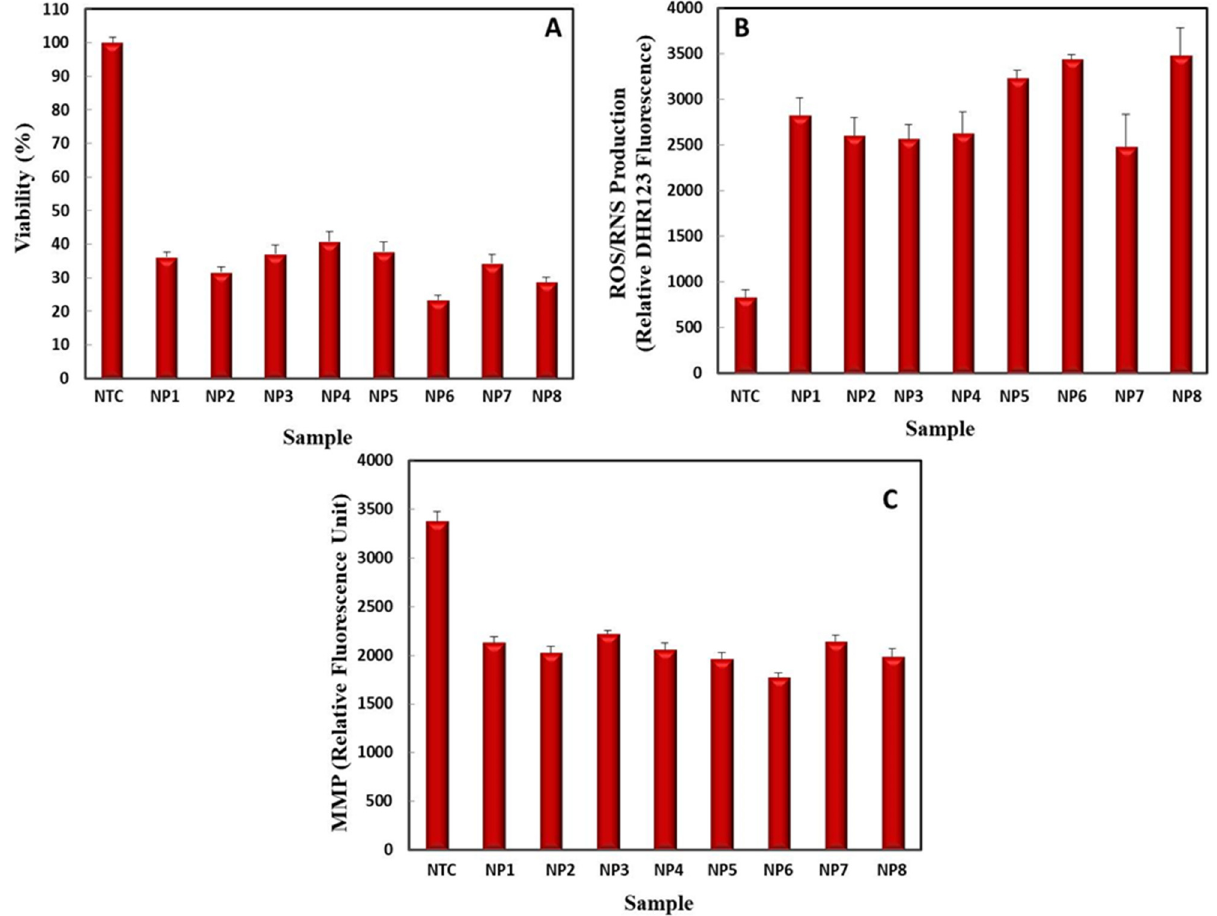
Figure 15. Anti-cancerous activities of monometallic and mimetallic NPs measured in terms of ( A ) cell viability, ( B ) intracellular ROS/RNS production, and ( C ) mitochondrial membrane potential disruption. Data represent the mean of 3 replicates ± SE. (Note—NTC: non-treated cells; NP1: control AgNPs; NP2: UV-C mediated AgNPs; NP3: control ZnONPs; NP4: UV-C mediated ZnONPs; NP5: control bimetallic Ag–ZnONPs (0.1/0.1); NP6: UV-C mediated bimetallic Ag–ZnONPs (0.1/0.1); NP7: control bimetallic Ag–ZnONPs (0.1/0.5); NP8: UV-C mediated bimetallic Ag–ZnONPs (0.1/0.5)).